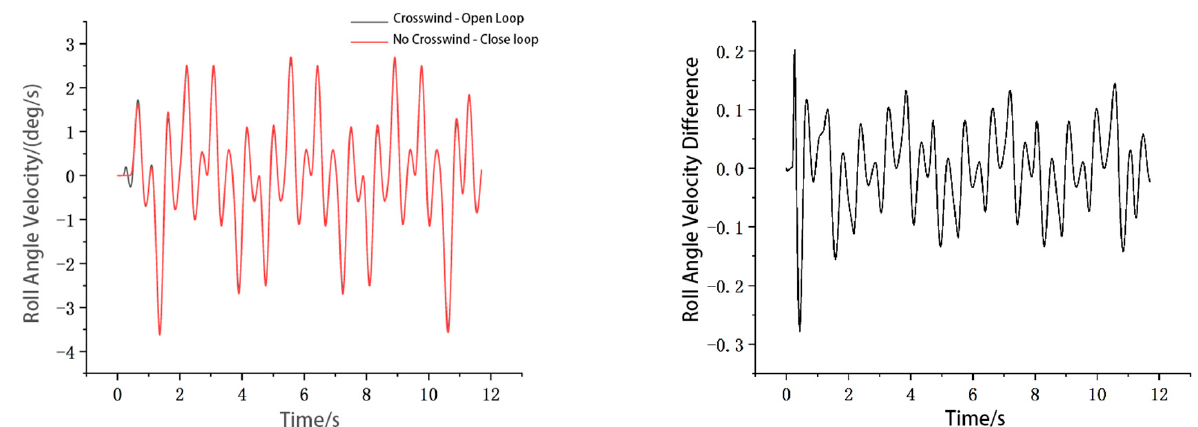
Figure 16. Comparison curve and difference curve of lateral acceleration with and without cross- wind effect.